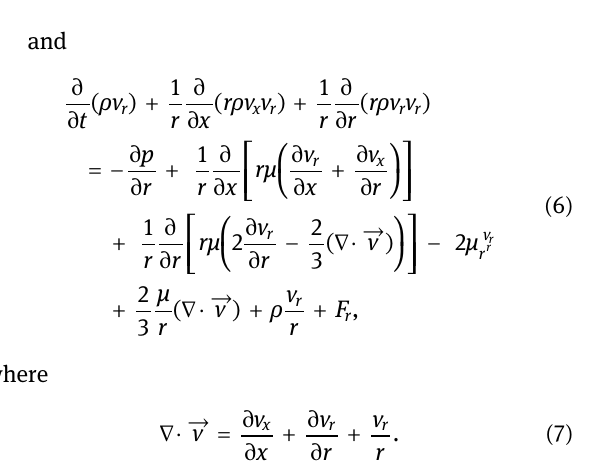
Figure 3: Geometry mesh.